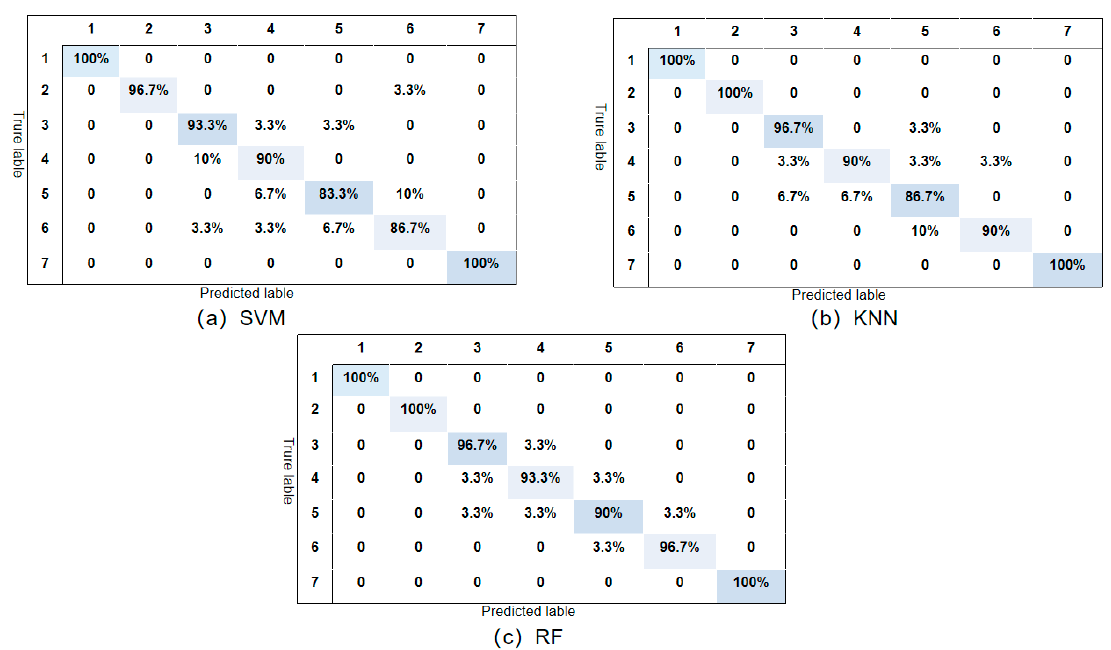
Figure 12. Average recognition accuracy of seven conditions in siphon.